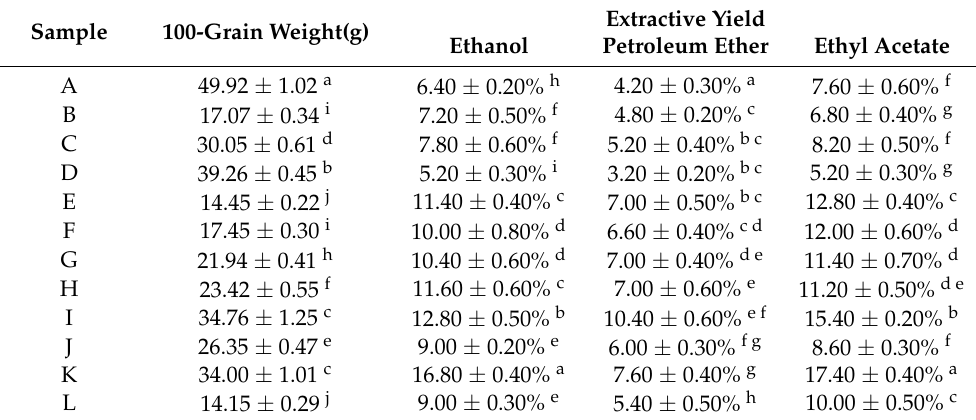
Table 2. 100-grain weight and extractives yield of the Alnus cremastogyne pod extractives.